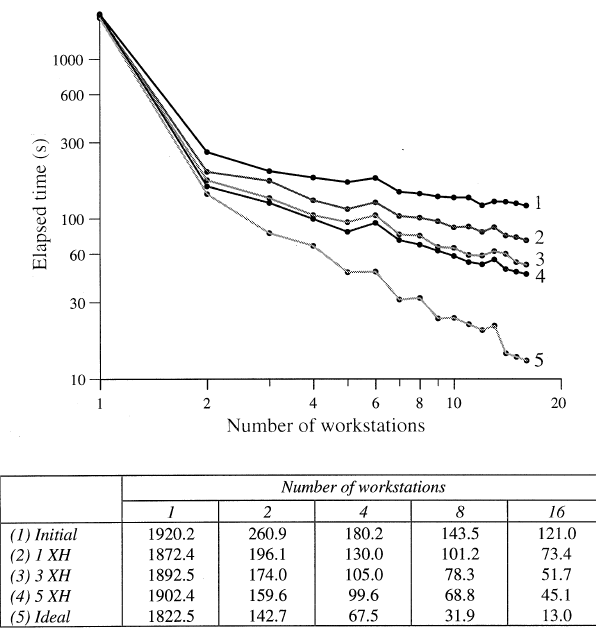
Fig. 5. Compared to (1) the initial implementation (when using FDDI), the performance of the code is significantly improved as the number of free-surface extra halos ( XH ) is increased in (2), (3) and (4)